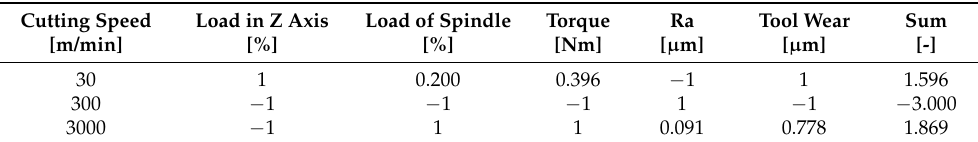
Table 12. Linear transformation of cutting speed influence on observed parameters during machining